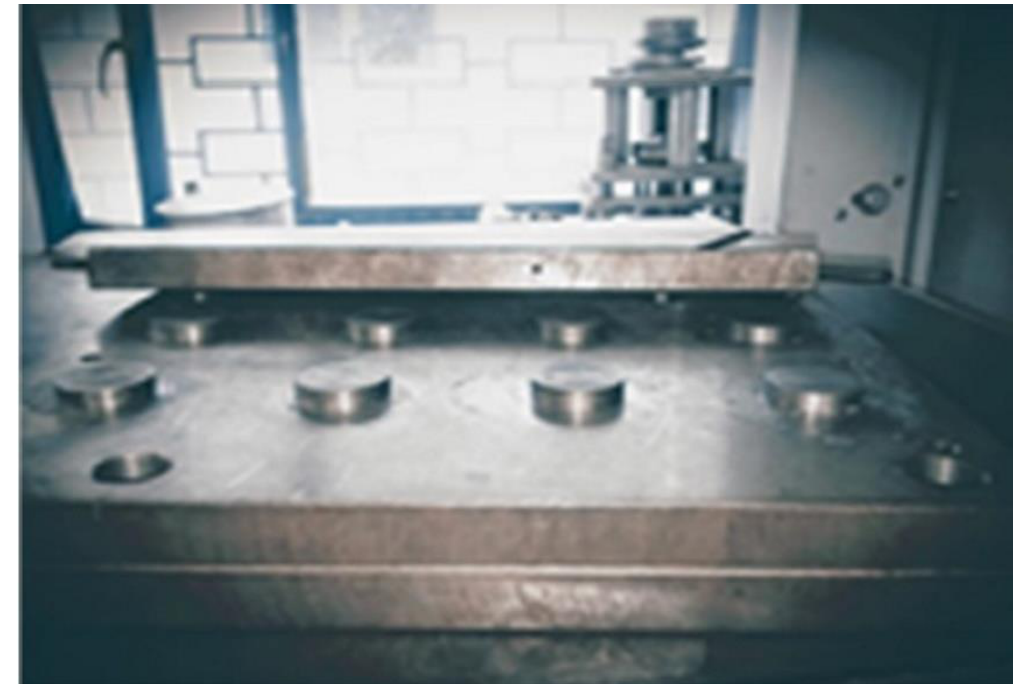
Figure 2. The used mould die for the briquetting process.